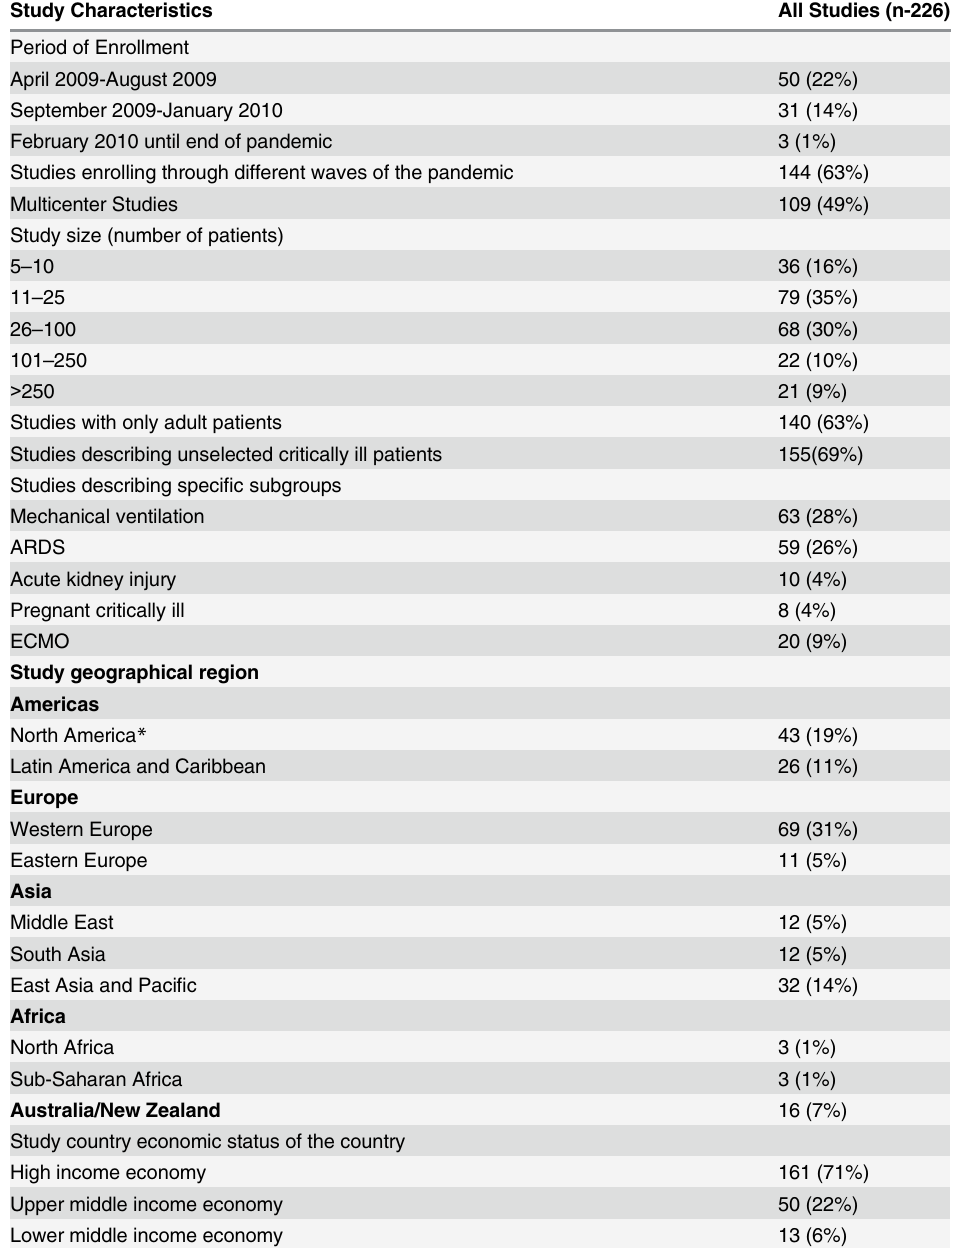
Table 1. System and study based characteristics described in 226 studies compared to the studies selected for the meta-regression and hierarchical model